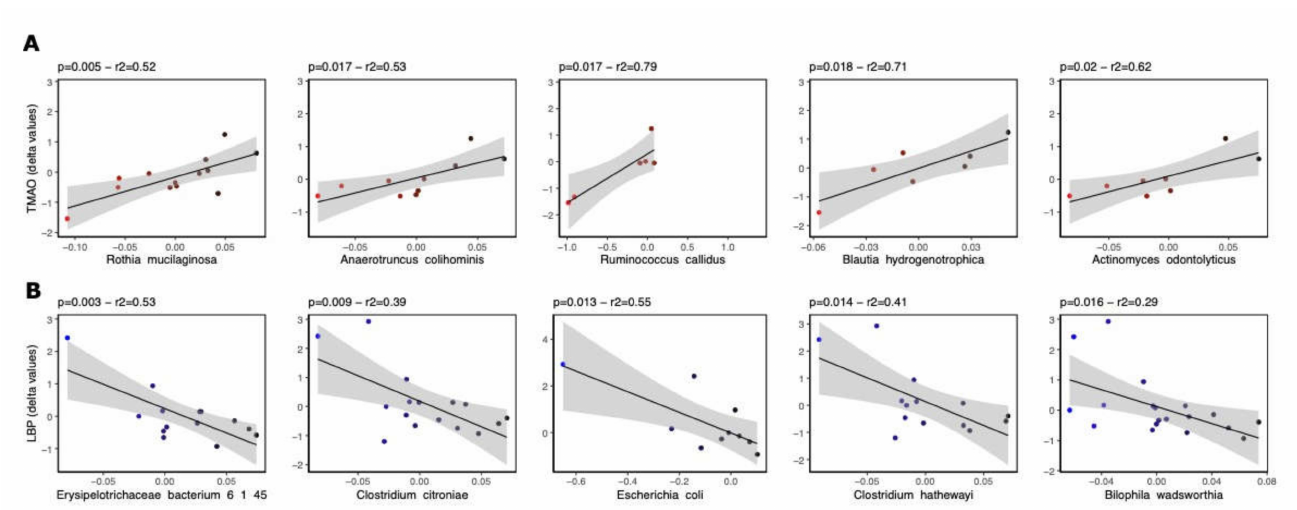
Figure 4. Association of fecal microbial abundance with plasma TMAO and LBP levels. The top five associations between fecal microbial abundance at the species level with TMAO and LBP plasma levels throughout the intervention (delta values) are shown in panels ( A , B ),